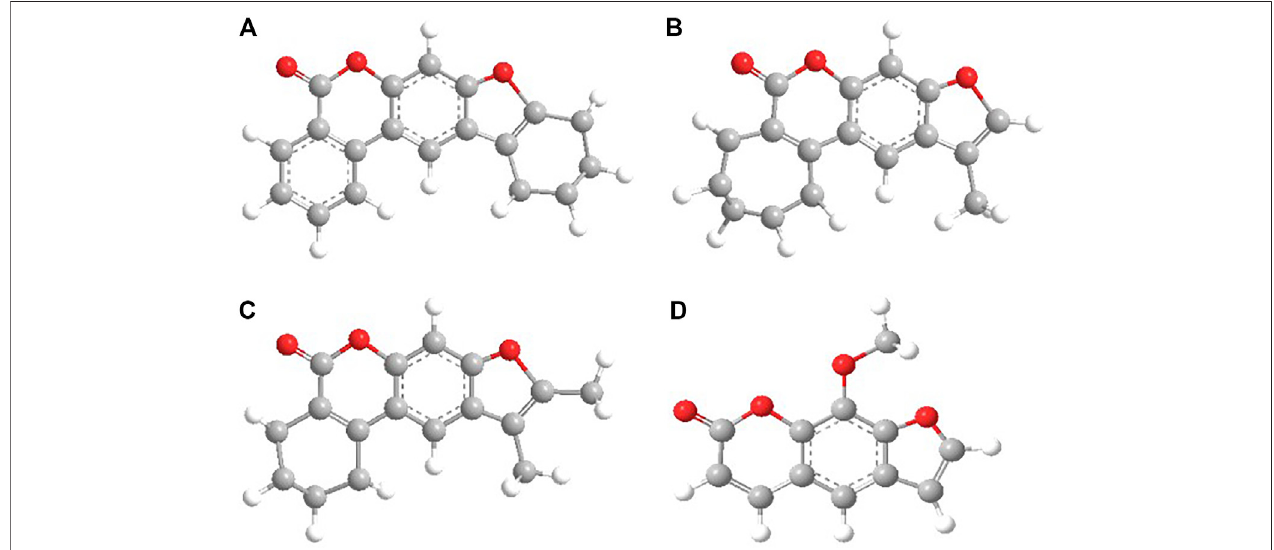
FIGURE 1 | Chemical structures of the studied molecules: (A) KC3; (B) KC4; (C) KC5; (D) 8-MOP.